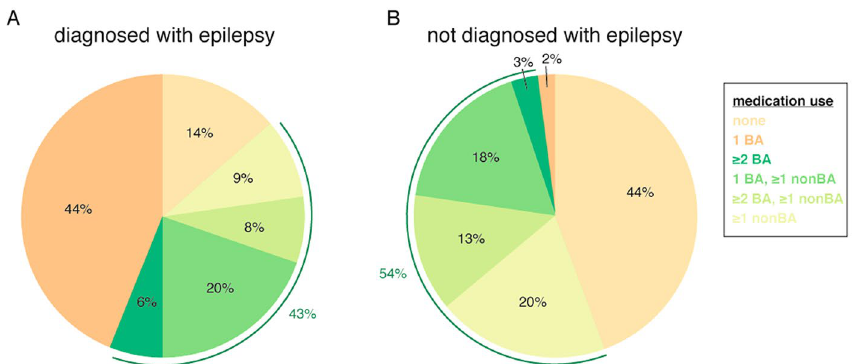
Figure 1. Brain- and non-brain-acting medication use in study sample. ( A ) Medication use in patients diagnosed with epilepsy (N = 66); ( B ) Medication use in patients without a diagnosis of epilepsy (N = 97). Indicators of comorbidities (use of multiple brain-acting medications, non-brain-acting medications, or both) shown in green. BA: brain-acting; nonBA: non-brain-acting. Figure panels created in MATLAB v.9.1 and merged using Adobe Illustrator CS6; colors were also edited in Illustrator for